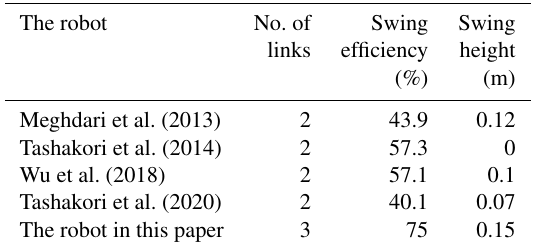
Figure 6. The angles of the brachiation robot. Table 2. Swing ability of different robots.